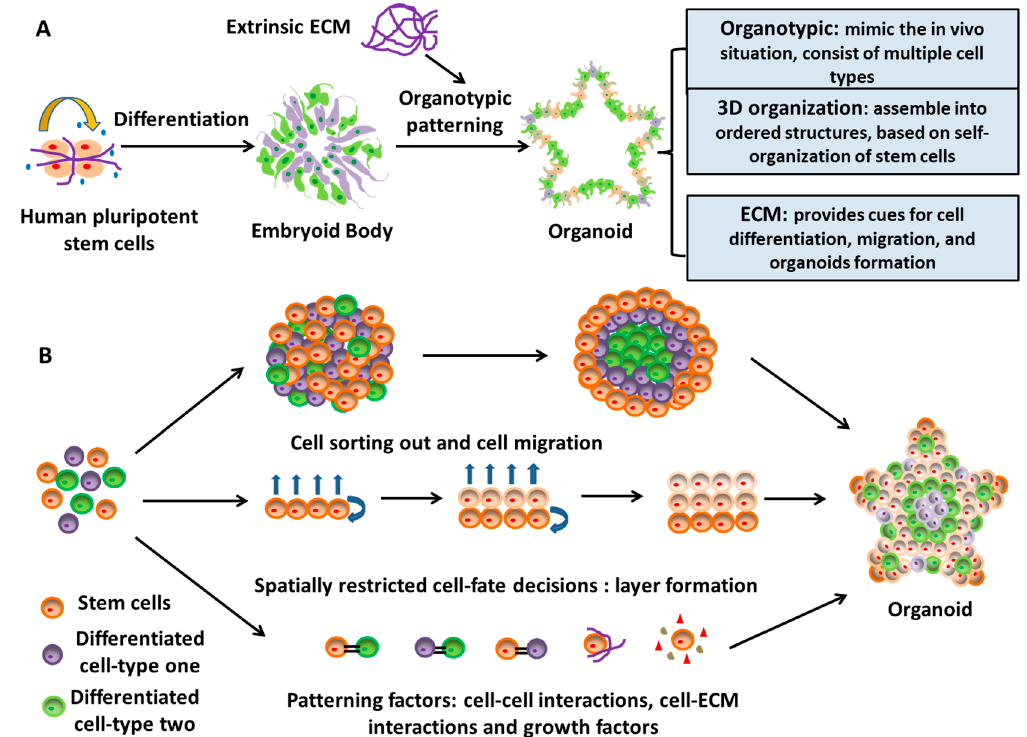
Figure 4. Organoid formation from human pluripotent stem cells. ( A ) Organoids can be generated from human pluripotent stem cells through the embryonic body (EB)-based procedure with the help of exogenous factors, such as extracellular matrix (ECM). Organoids form 3D ordered structures to mimic the in vivo situation of tissues or cells. ( B ) Organoids form based on the self-organization and self-assembly of stem cells.